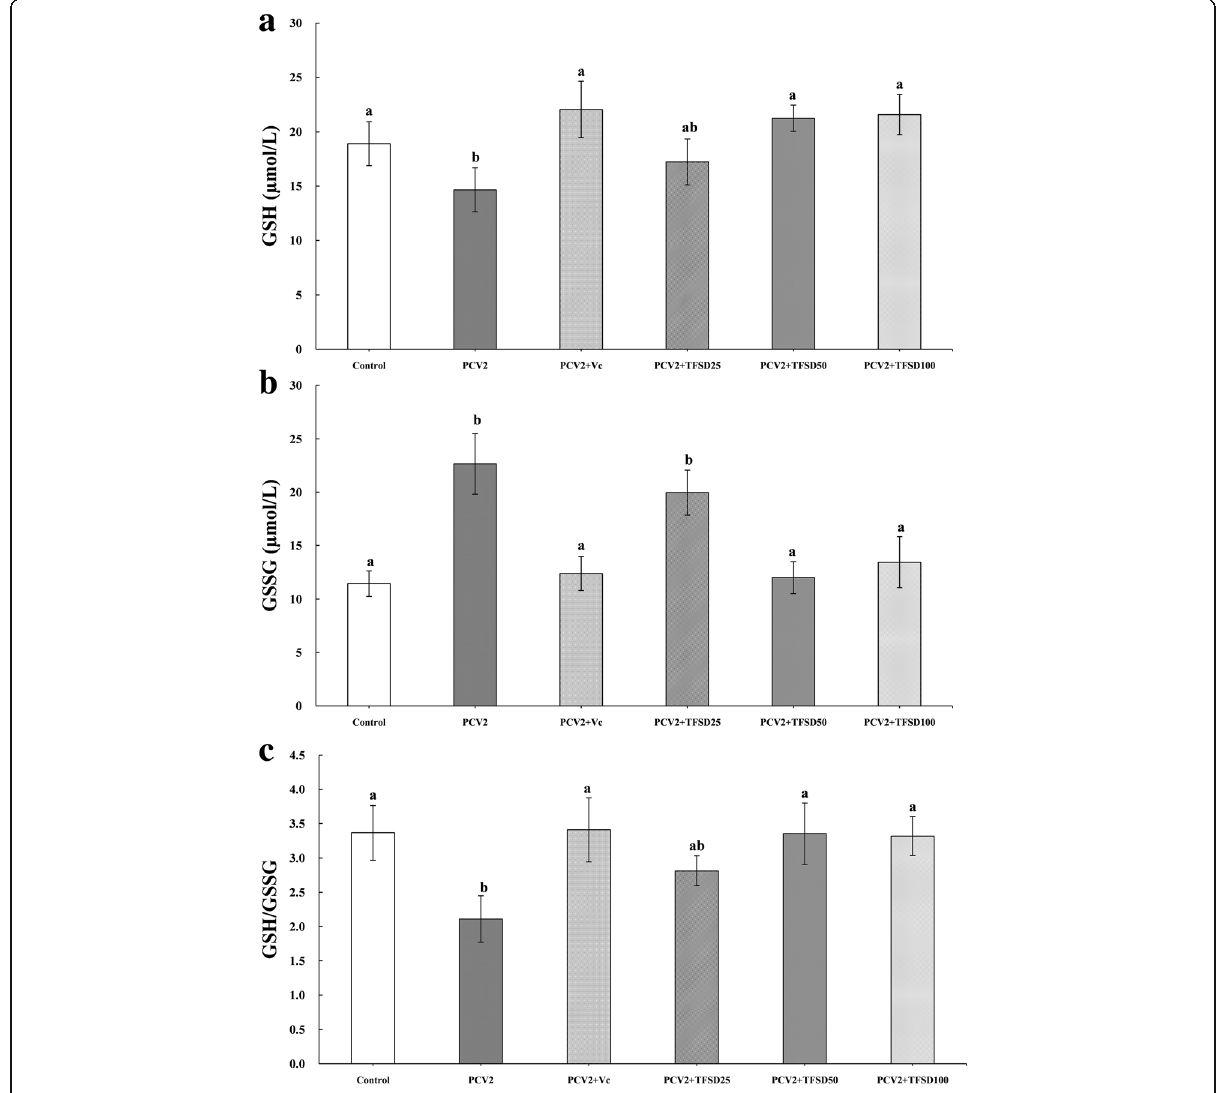
Fig. 3 Effect of TFSD on intracellular GSH concentration ( a ), GSSG content ( b ) and GSH/GSSG ratio ( c ) in PCV2 infected RAW264.7 cells. Data are presented as mean ± S.D. Bars with different letters are statistically different ( P < 0.05). Control: cells without PCV2 infection and drug treatment; PCV2: cells infected with 10 2.7 TCID 50 PCV2; PCV2 + Vc: cells treated with 100 μ g/mL of vitamin C after PCV2 infection; PCV2 + TFSD25 – 100: cells treated with TFSD at concentrations of 25, 50 or 100 μ g/mL after PCV2 infection,